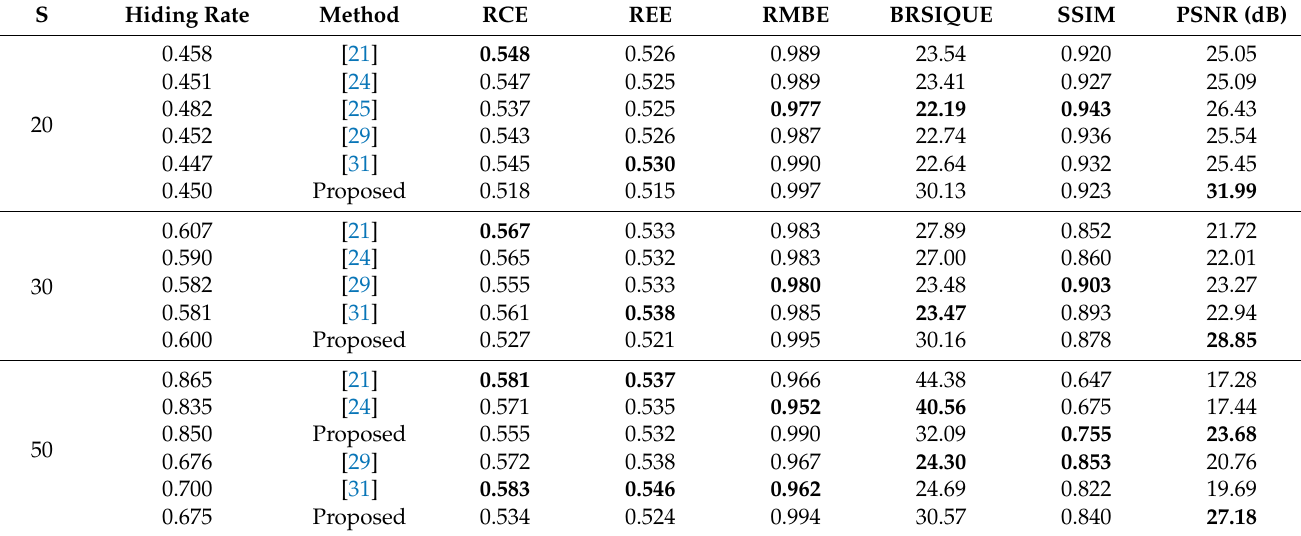
Table 4. Average metrics with USC-SIP dataset using F , C = 8 for BS embedding.